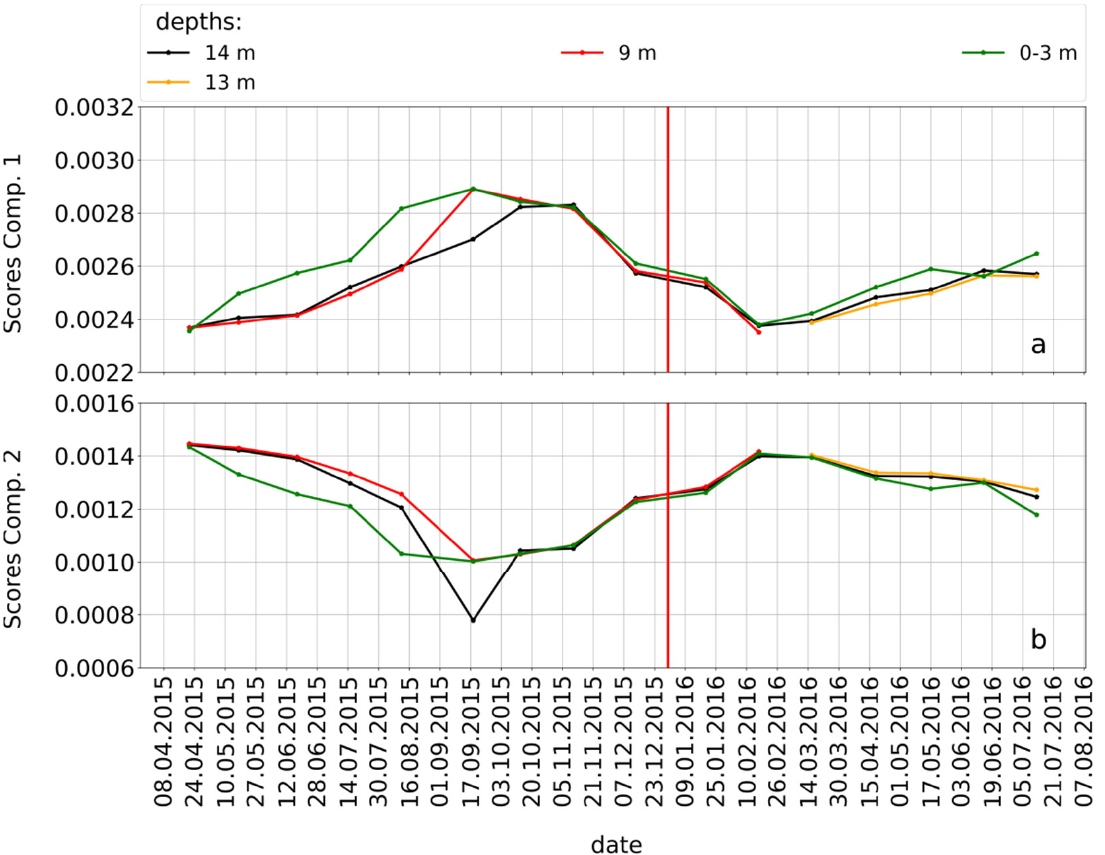
Figure 2. Distribution of scores of identified PARAFAC component 1 ( a ) and component 2 ( b ) at the three investigated depths (bottom: 14 m; mid: 9–13 m and surface water) of the reservoir.